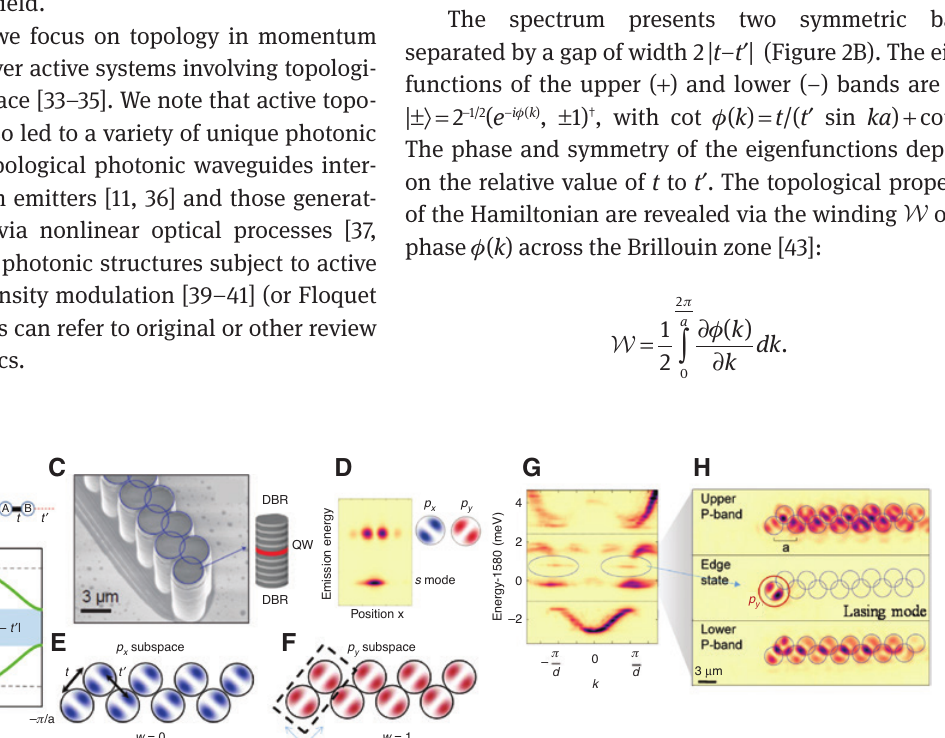
and p subspaces of x y